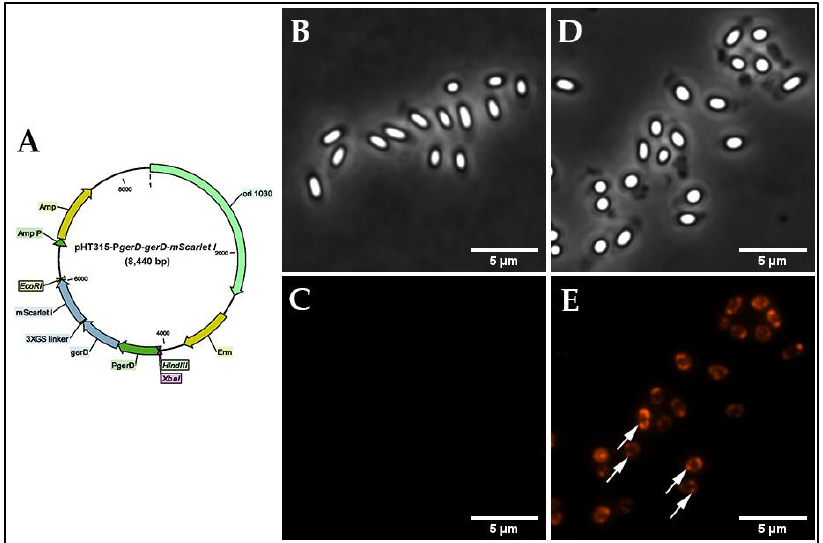
Figure 4. Percentage of germinosomes in dormant spores of B. cereus 003, B. cereus 006 and B. cereus 007. The germinosome in individual B. cereus 003 spores carrying pHT315-P gerR - gerRB - SGFP2 , B.